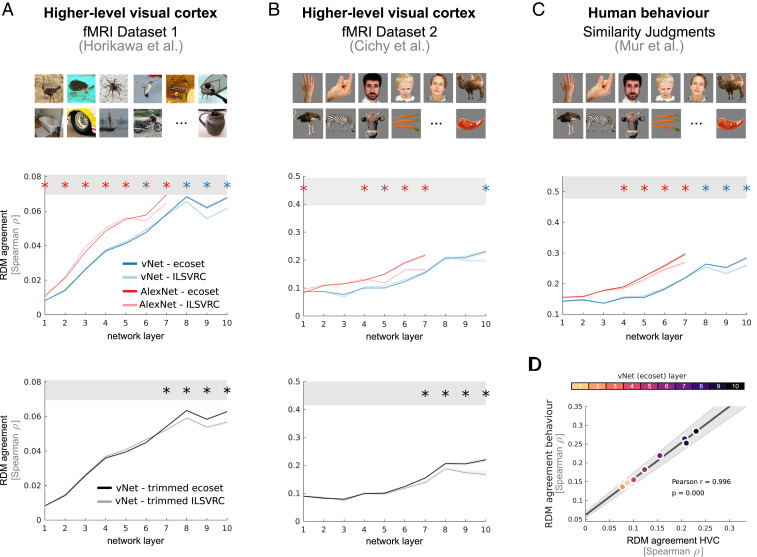
Training on ecoset rather than ILSVRC 2012 improves the alignment between DNN representations and human HVC as well as with human perceptual similarity judgments. (A) Data for fMRI dataset 1. (A, middle row) Benefits of training on ecoset were true for both architectures tested (AlexNet, shown in red, as well as vNet, shown in blue). Lower bound of the noise ceiling shown as the lower edge of the gray bar, stars indicate significant differences at P < 0.01, Bonferroni corrected for the number of network layers. To estimate statistical significance, each network instance of a given architecture was correlated with data from each human participant. To summarize the performance of a network instance, the average match across all human individuals was computed. Based on these data, permutation tests were performed comparing network instances trained on either ecoset or ILSVRC. Error bars indicate 95% CI across network instances (see Materials and Methods for further details). (A, bottom row) Benefits of training on ecoset persist when controlling for the number of images and the number of categories in the two training datasets. (B) Effects obtained for fMRI dataset 1 replicate in a separate fMRI dataset (dataset 2). (C) DNNs trained on ecoset also exhibit better alignment with human perceptual similarity judgments (behavioral dataset, ecoset-trained network shown in black, ILSVRC 2012 in gray). (D) The model fit between HVC and human behavior exhibits a strong positive relationship (data for various vNet network layers shown as data points).